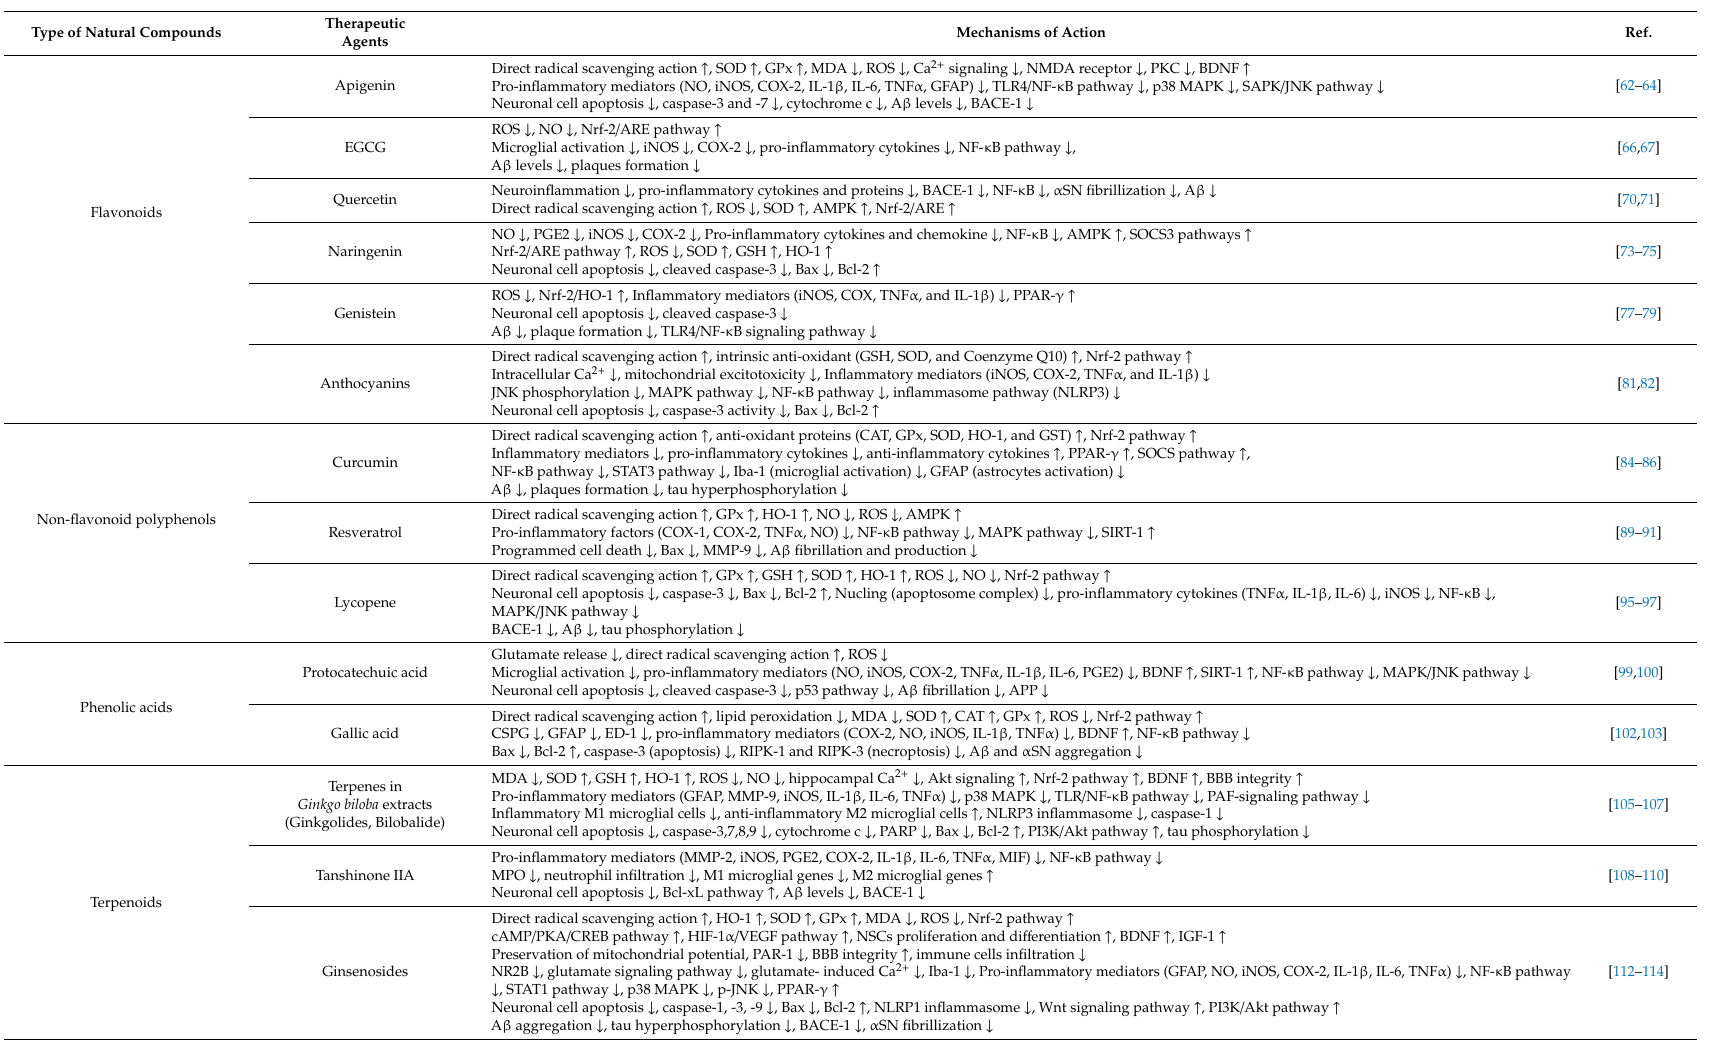
Table 1. Potential natural compounds for the treatment of CNS